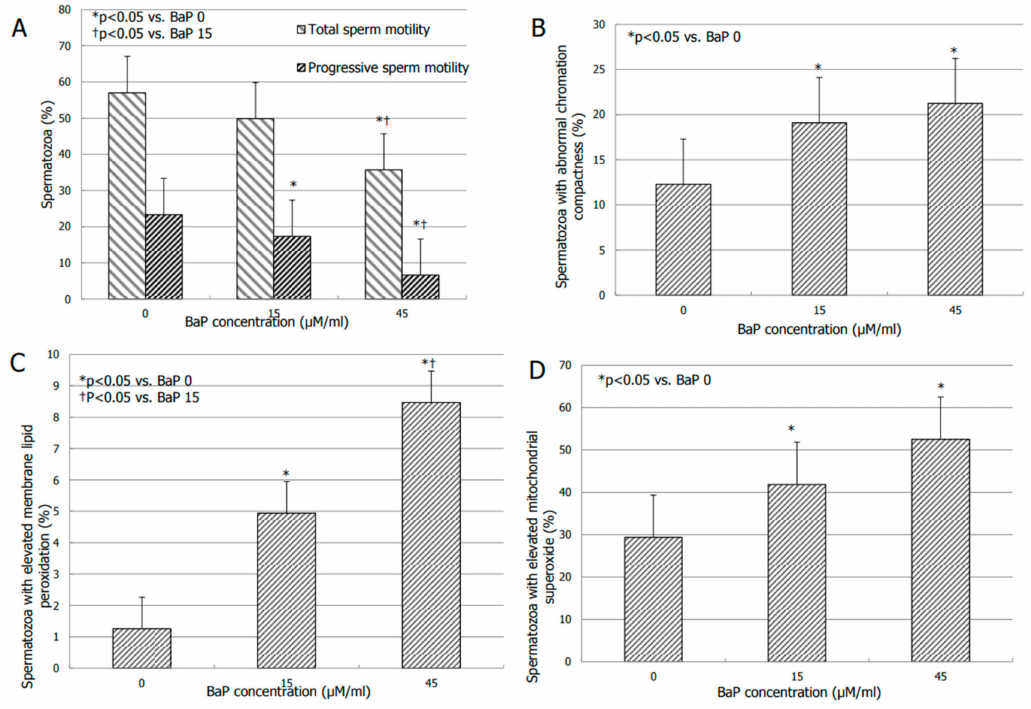
Figure 1. E ff ects of increasing concentrations of benzo– α –pyrene (BaP) on total and progressive sperm motility ( A ), degree of chromatin compactness ( B ), membrane lipoperoxidation ( C ) and the amount of mitochondrial superoxide ( D ) after 3 h of incubation on spermatozoa of normozoospermic men.